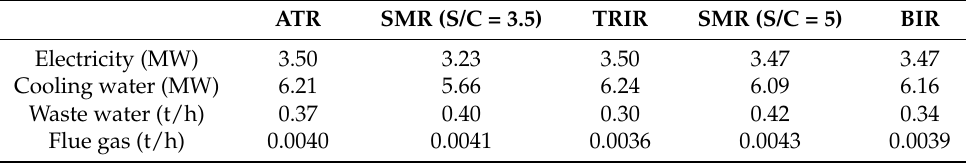
Table 14. Utilities and waste streams for CO 2 compression from 1.95 to 150 bar.